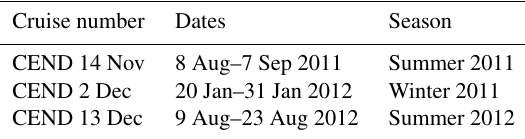
Table 1. Summary of sampling cruises in the North